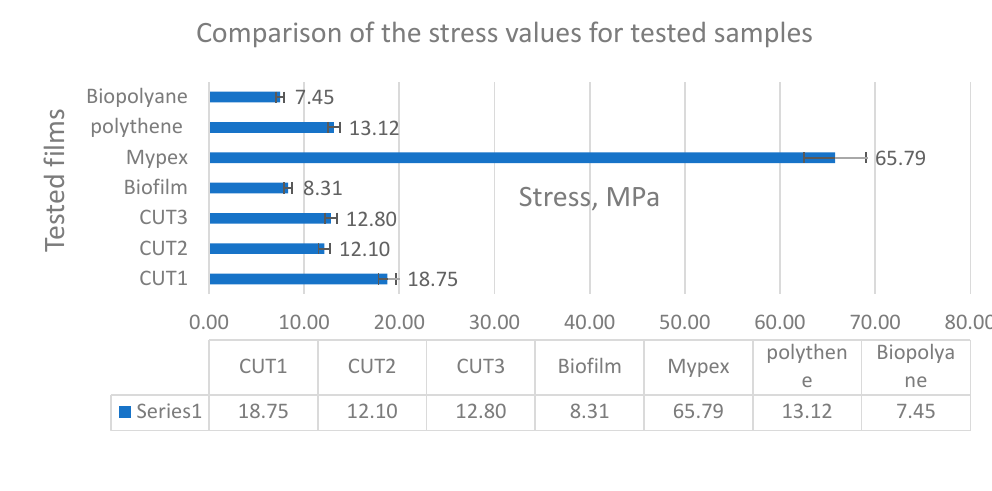
Figure 4. Comparison of the maximum stress obtained in the static tensile strength test.